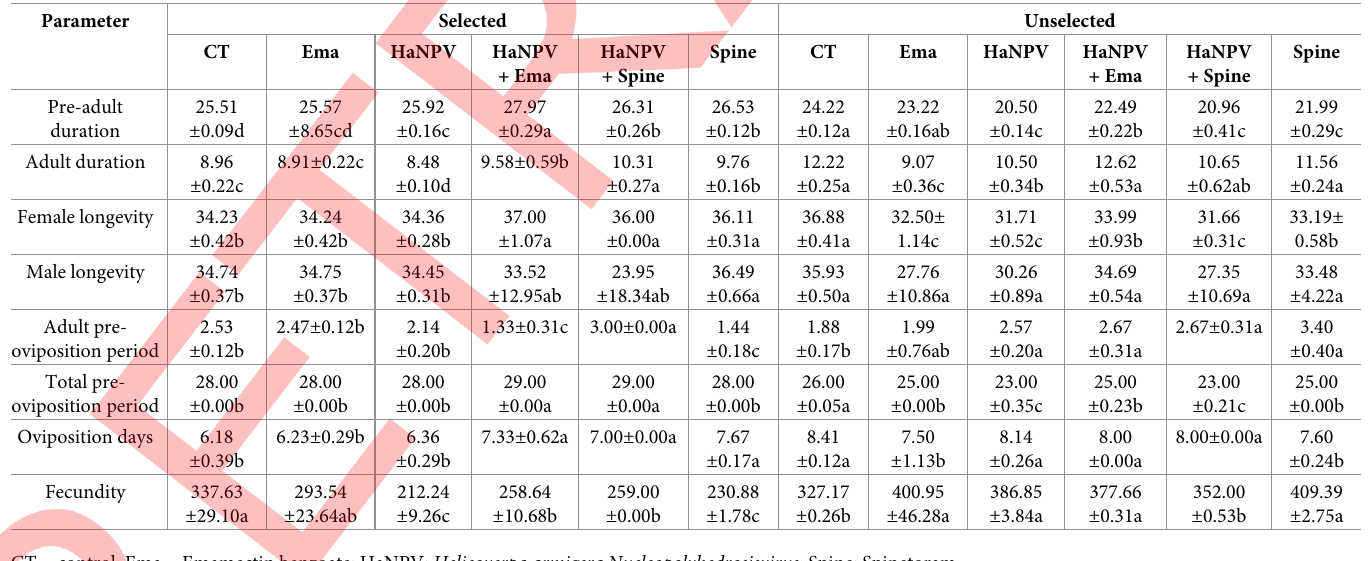
Table 2. Effect of HaNPV, insecticides and their combinations on emamectin benzoate selected and unselected population of Helicoverpa armigera .